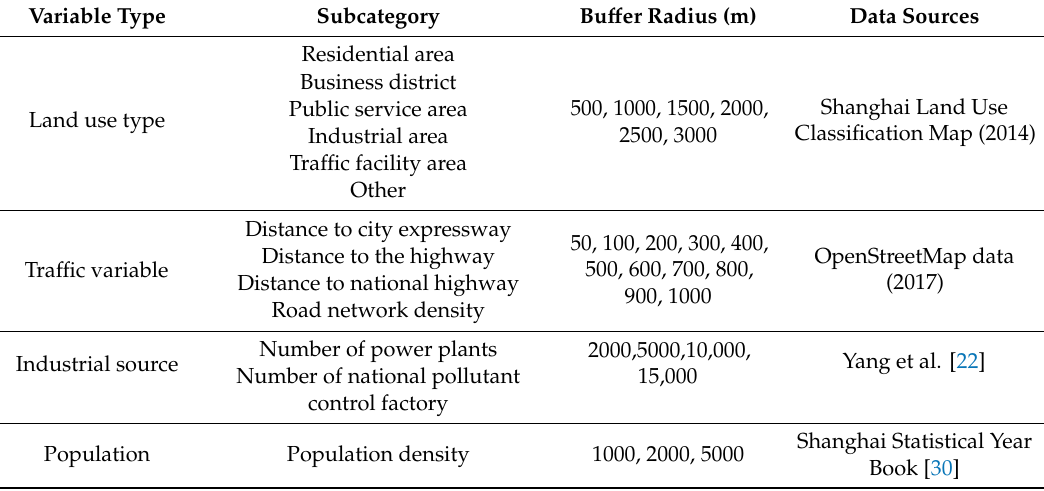
Table 1. Potential predictor variables influencing mercury